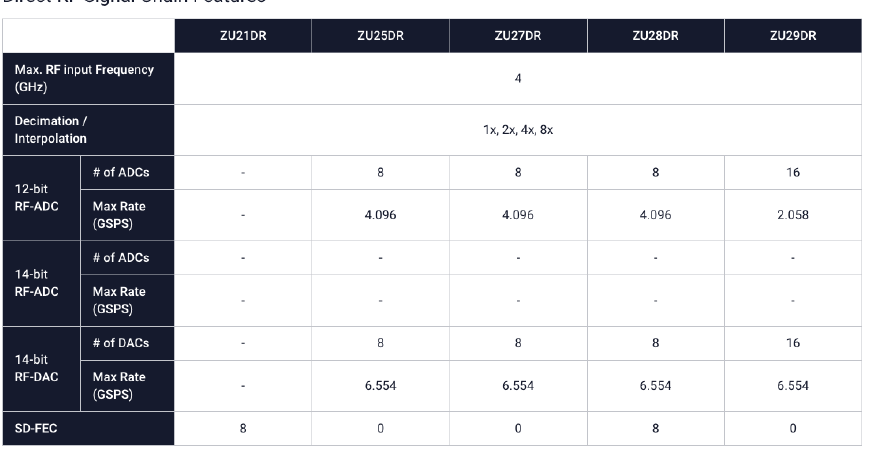
Figure 13. RFSoC features’ comparison